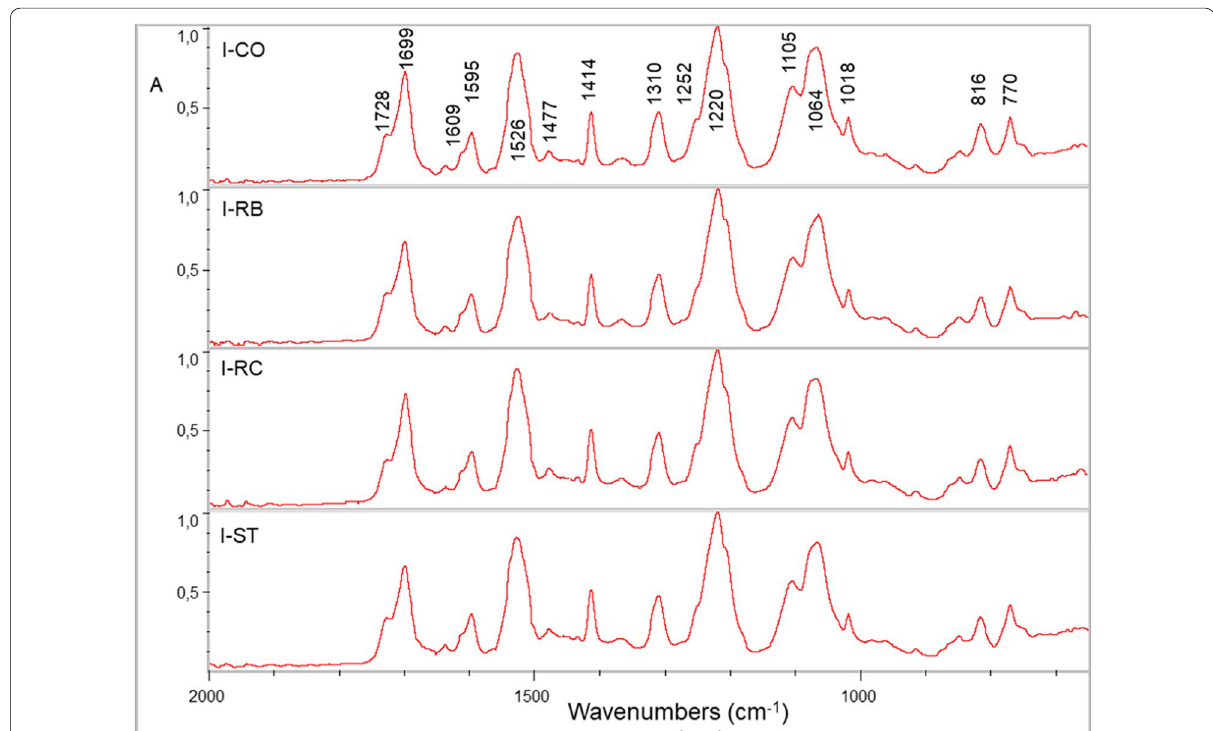
Fig. 4 ATR-FTIR spectra of Invisalign (I) before (CO) and after treatments with Retainer Brite (RB), Retainer Cleaner (RC) and Steraligner (ST) cleaners. Spectra are identical (expanded 2000–650 cm − 1 range, absorbance scale)